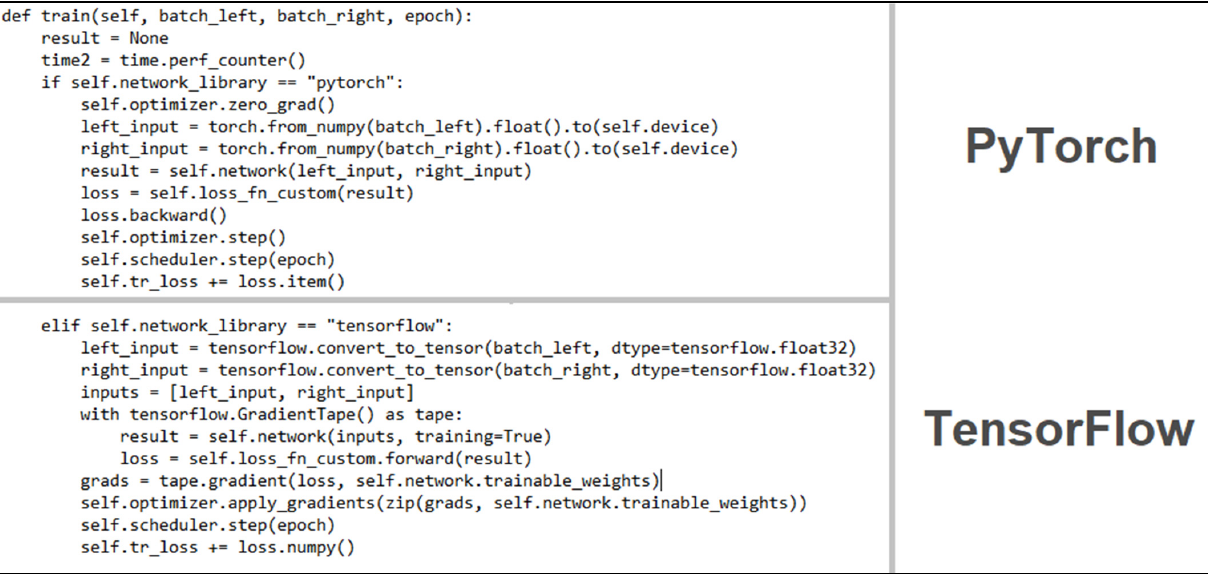
Figure 8. Training flow.